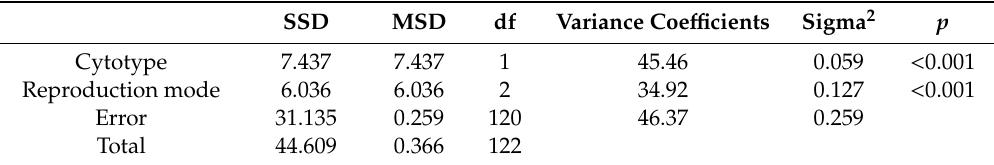
Table 1. Hierarchical AMOVA (analysis of molecular variance) of epiloci with cytotype as first and reproduction mode as the second